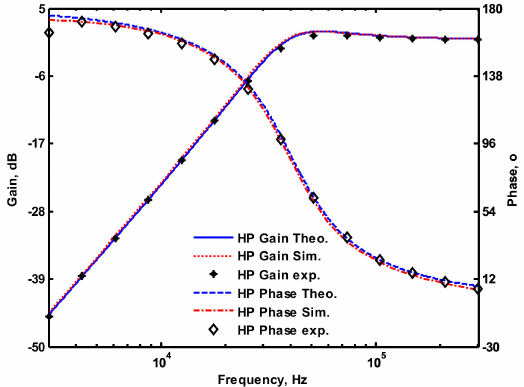
Figure 10. Simulation and experimental results of IBP filtering responses at V o1 when V i1 = 0 and V i2 = V in .